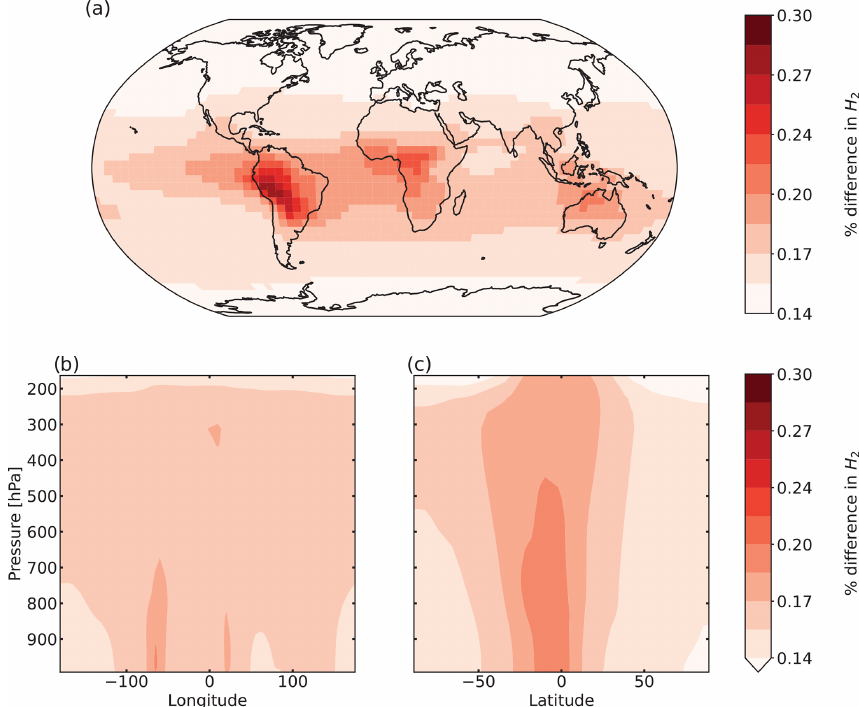
Figure 7. Same as Fig. 6 but for average H 2 mixing